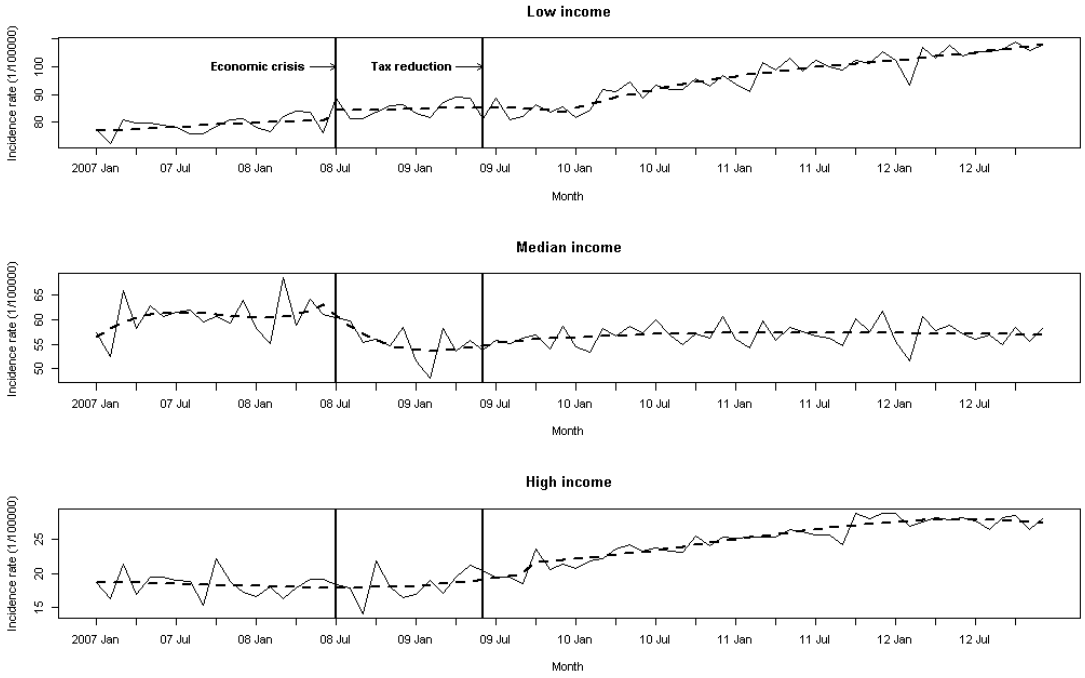
Figure 1. Monthly alcohol-attributed incident rates of hospitalization (per 100,000 persons) and a one-step ahead forecast with economic and tax intervention.